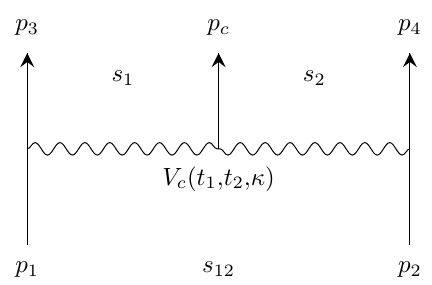
Figure 2. A schematic representation of the factorized two-to-three amplitude in eq. (4.7).